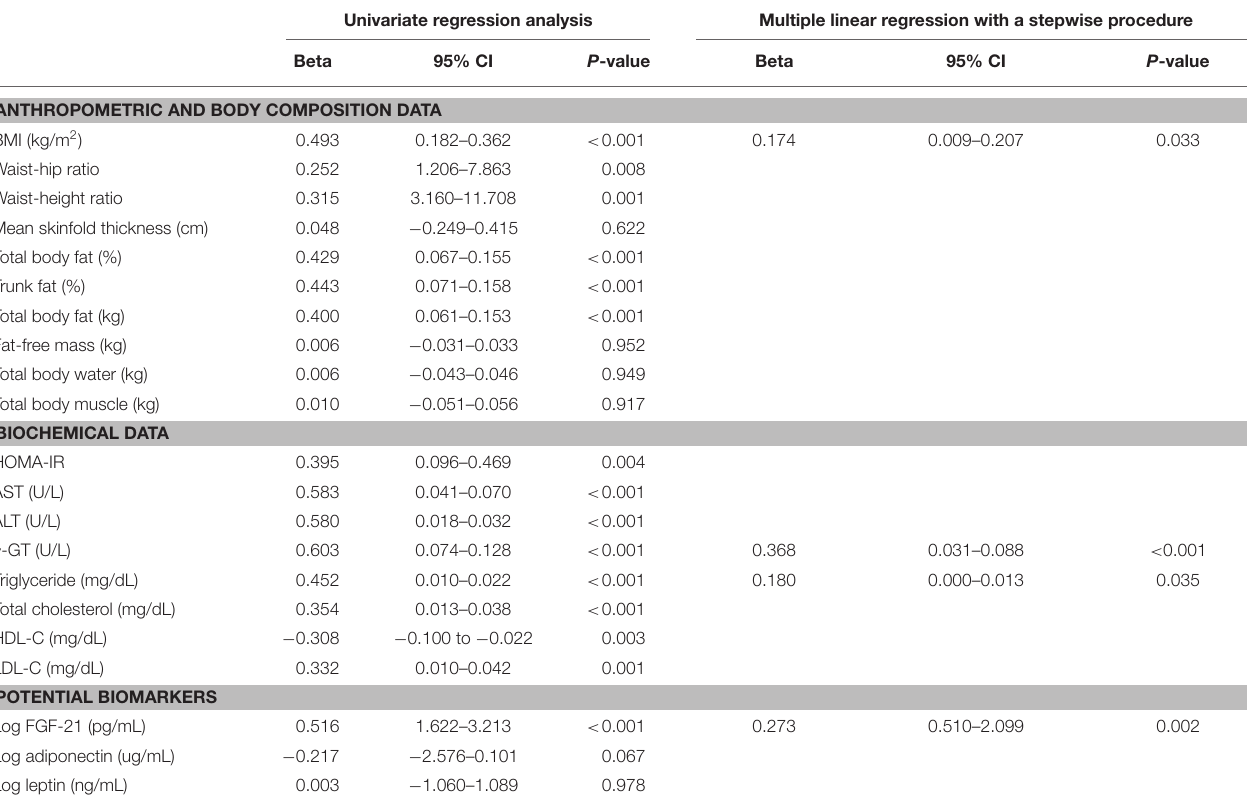
TABLE 2 | Regression analysis of clinical and laboratory parameters in relation to NAFLD score in obese and overweight children. Univariate regression analysis Multiple linear regression with a stepwise